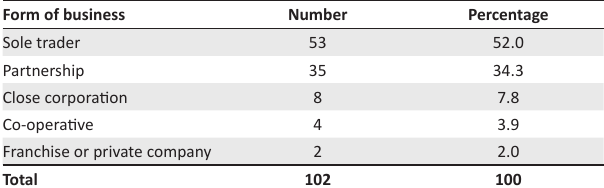
TABLE 3: Respondents’ form of business.